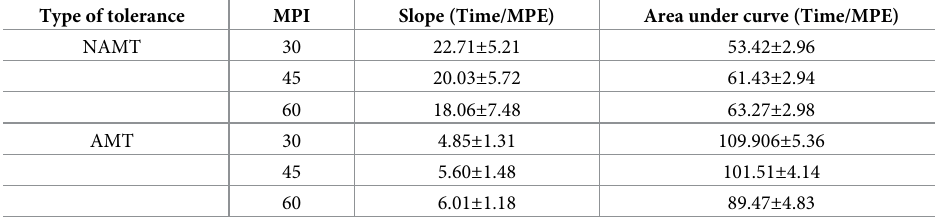
Table 2. Comparison between area under curve and slope in NAMT and